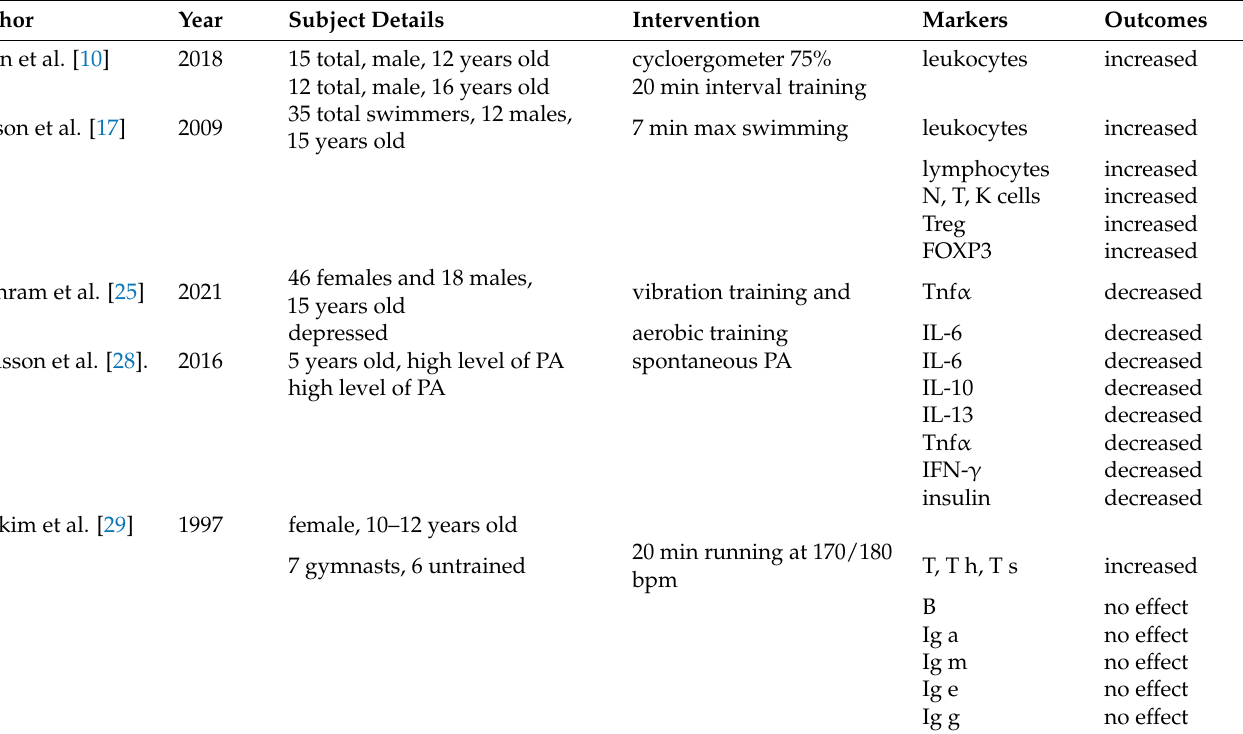
Table 1. Summary of the studies reporting acute effect of exercise on markers of immunity in